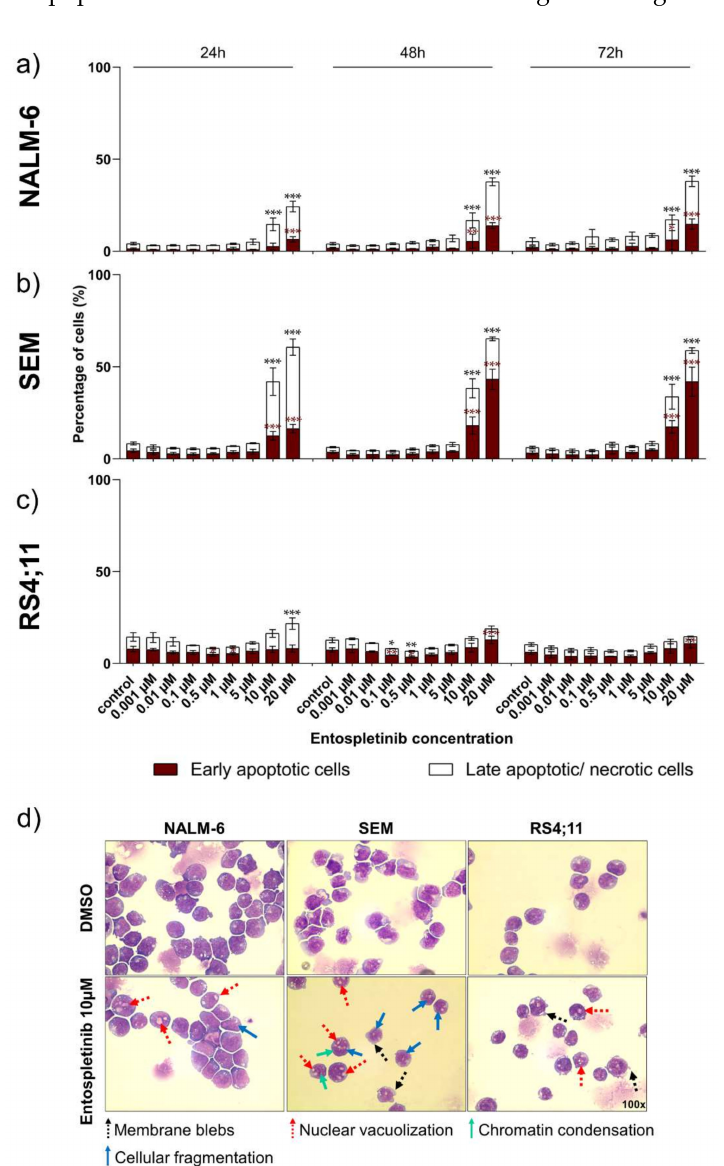
Figure 4. Apoptosis induction in B-ALL after entospletinib (Ento) exposure. Concentration-dependent apoptosis induction by entospletinib in pre-B-ALL NALM-6 and pro-B-ALL SEM. B-ALL cells were exposed to serially diluted entospletinib concentrations (0,001 µ M–20 µ M). Apoptosis induction was determined by Annexin V/PI staining for an exposure time of 24 h, 48 h and 72 h. ( a ) NALM-6 cells, ( b ) SEM and ( c ) RS4;11, respectively. ( d ) Representative light microscopy images ( × 100) of entospletinib-exposed B-ALL cells after 72 h. Cytospins were stained with May-Gruenwald Giemsa stain (Pappenheim method) after 24 h, 48 h and 72 h entospletinib exposure at different concentrations (1 µ M, 5 µ M and 10 µ M). Data are presented as the mean ± SD. Statistical significance was calculated by one-way ANOVA followed by Dunnett’s test as a post-hoc analysis and displayed as * p < 0.033, ** p < 0.002, *** p < 0.001 versus the control group ( n ≥ 3). Black asterisks indicate significance of late apoptotic/necrotic cells and red asterisks indicate significance of early apoptotic